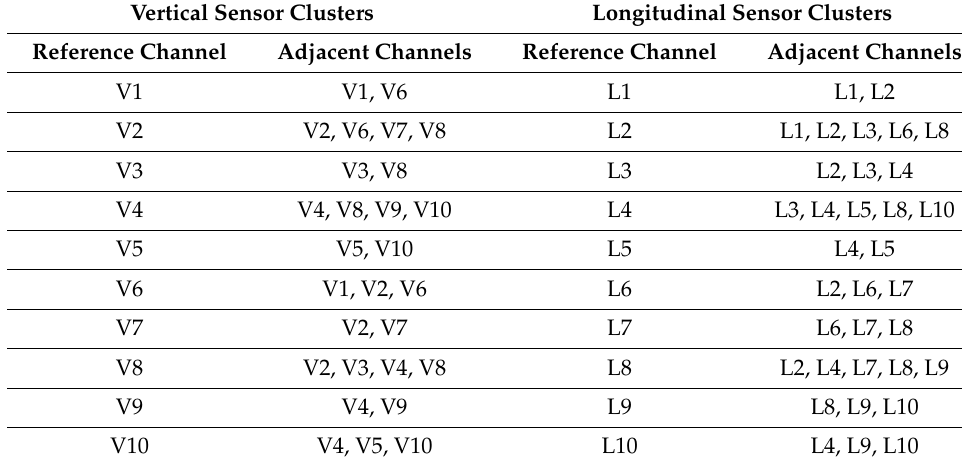
Figure 3. Location of accelerometers and their designations. Table 1. Sensor clusters for the truss bridge.